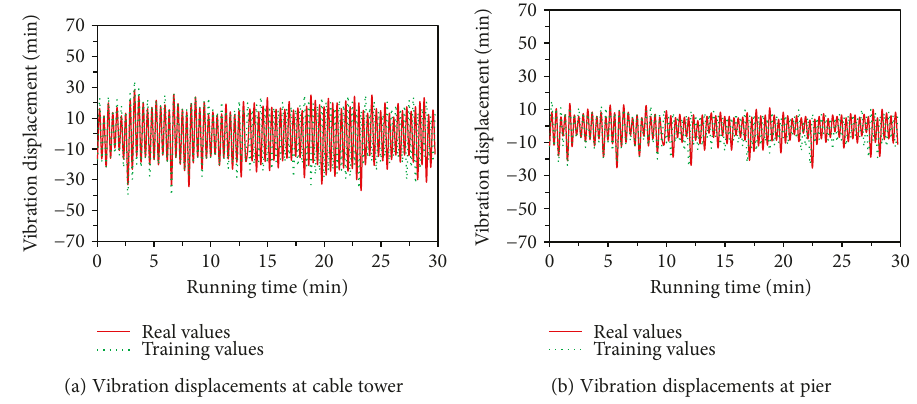
Figure 12: Training of PSO-BP neural network